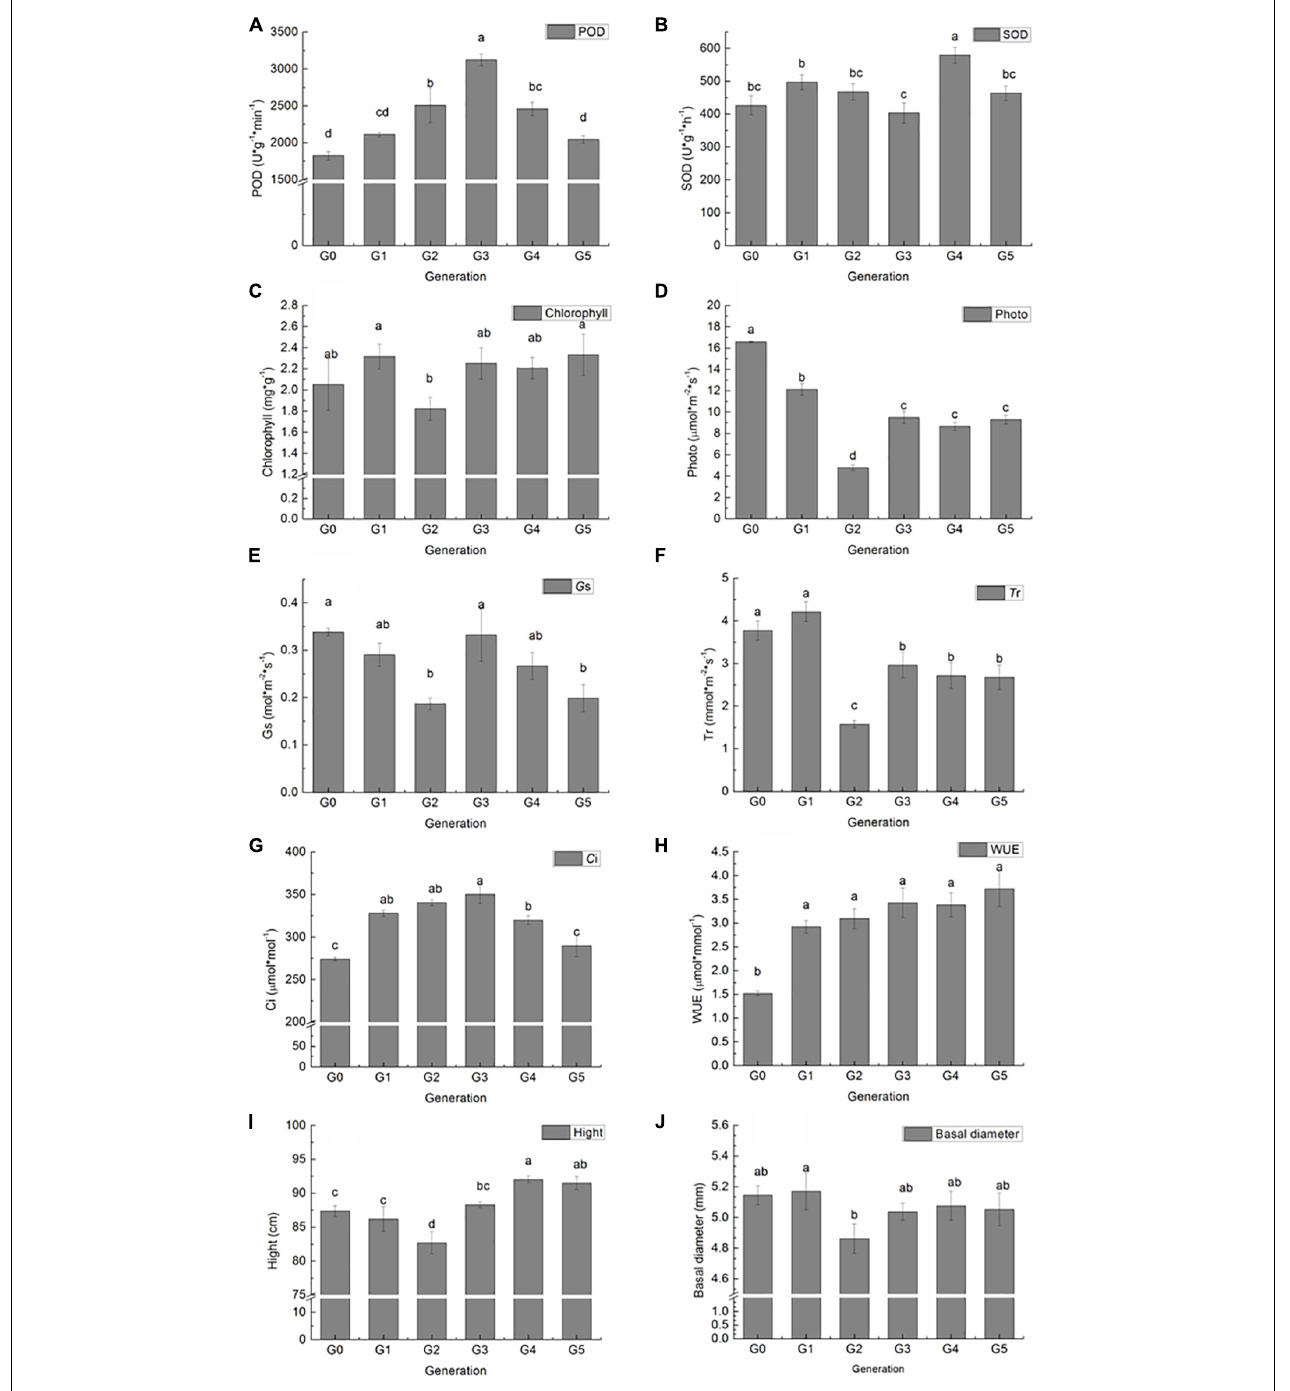
FIGURE 2 | Variation in P. nigra physiological and growth parameters among regenerated plants of five generations compared with those of donor plants. (A) POD activity. (B) SOD activity. (C) Chlorophyll content. (D) Photosynthetic rate. (E) Stomatal conductance. (F) Transpiration rate. (G) Intercellular CO2 concentration. (H) Instant water use efficiency. (I) Height. (J) Basal diameter. Different letters on columns indicate significant differences at P < 0.05.